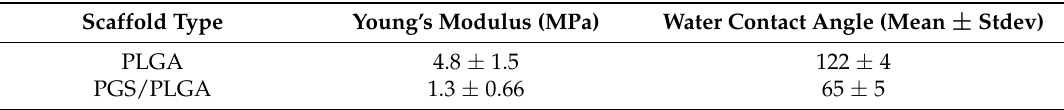
Table 1. Properties of PLGA and PGS/PLGA nanofiber